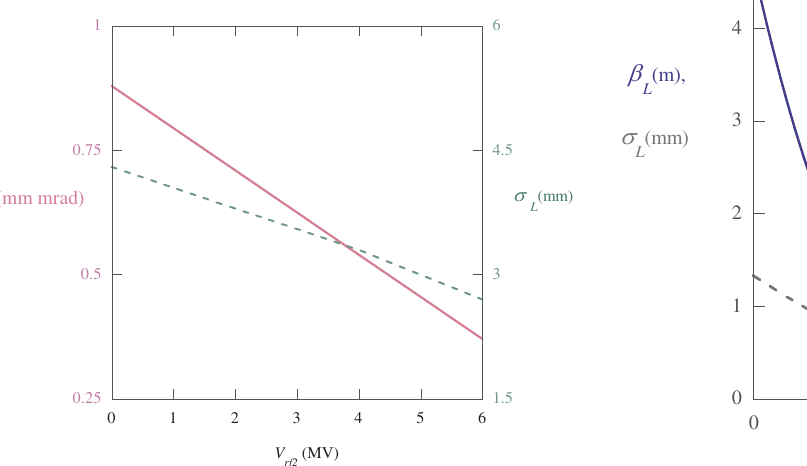
FIG. 15. (Color) Emittance (full pink line) and energy spread (green dashed line) as a function of the second rf cavity voltage (cid:6) 4 MV . for V rf1